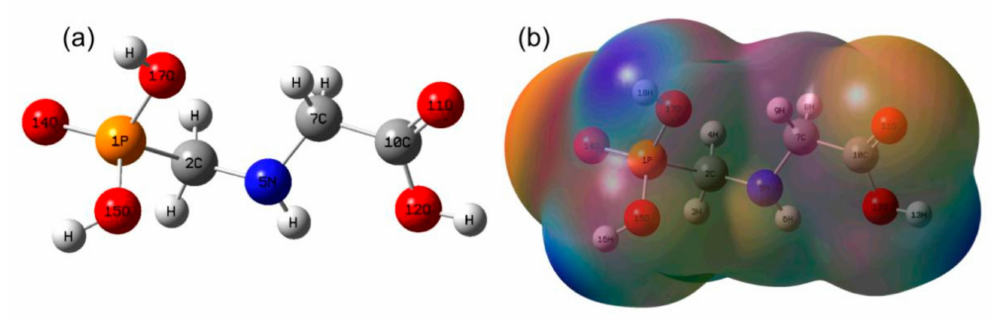
Figure 1. Optimized geometry and molecular electrostatic potential (MEP) mapping of glyphosate with / without 2- 13 C-isotope labeled ( a ) Optimized geometry of glyphosate with / without 2- 13 C-isotope labeled, ( b ) MEP mapping of glyphosate with / without 2- 13 C-isotope labeled. Table 1. Summary calculated and observed normal Raman scattering / Fourier Transform